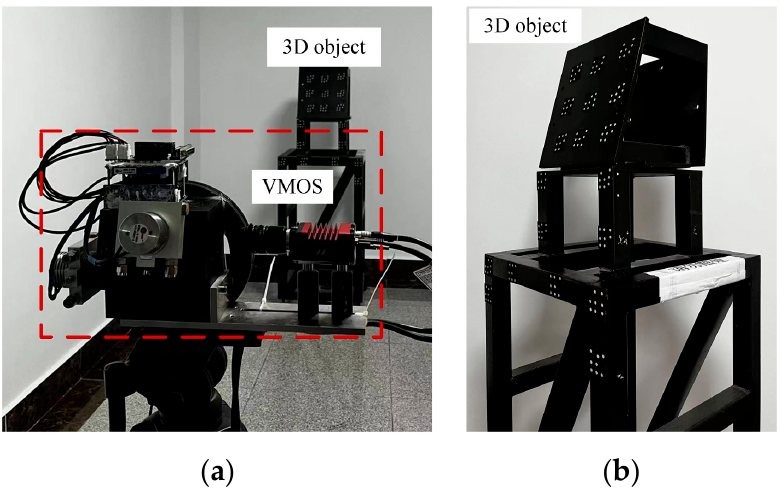
Figure 15. Scene of the 3D object reconstruction experiment. ( a ) The experiment scene. ( b ) The 3D object with marker points.